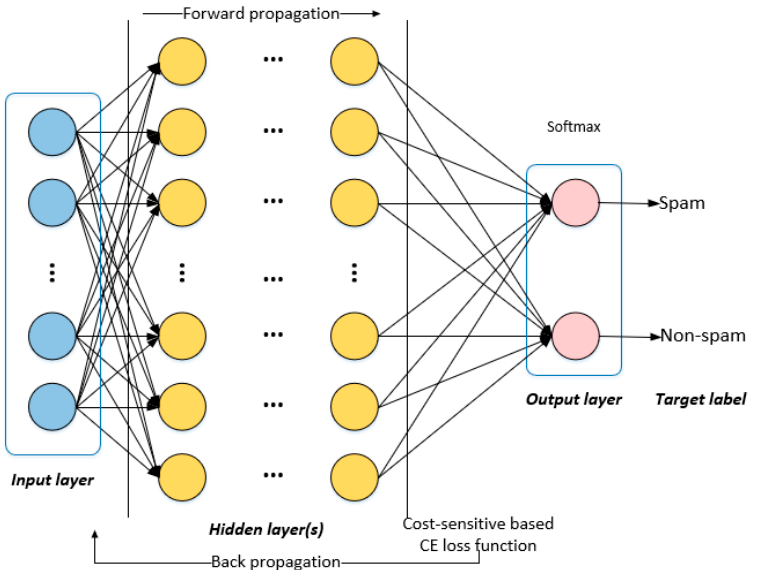
Figure 3. Schematic of the deep neuron networks.